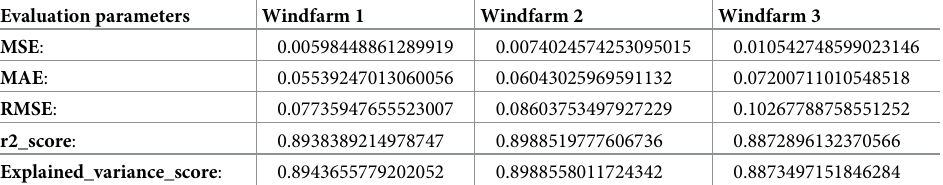
Table 7. This table shows the final result for 200 epochs and the optimal time step found using simulated annealing. Evaluation parameters